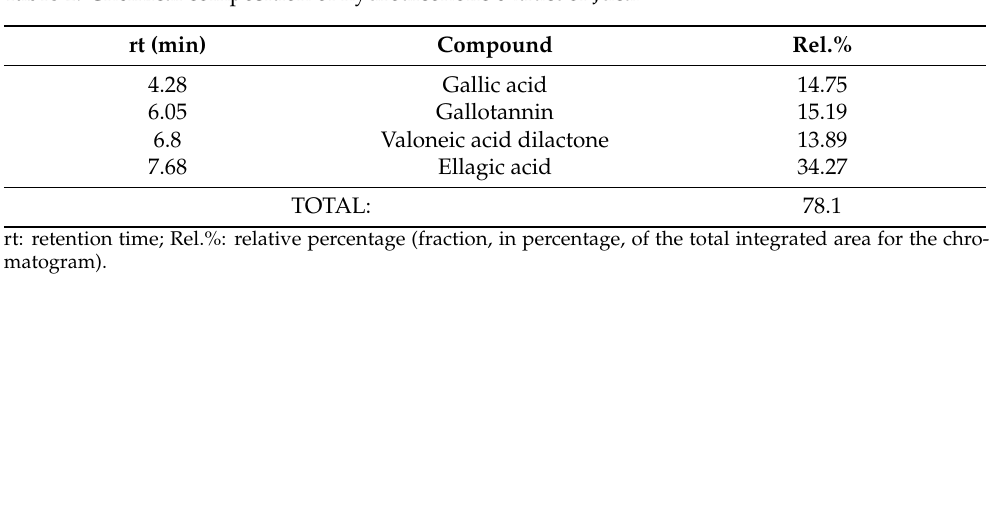
Table 1. Chemical composition of hydroalcoholic extract of Juc á